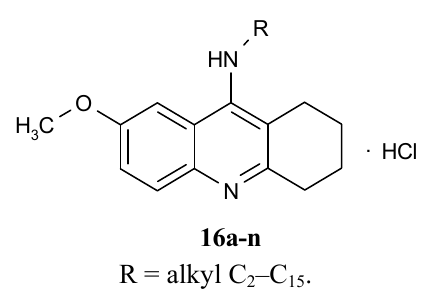
Figure 6. N -Alkyl-7-MEOTA hydrochlorides 16a–n .